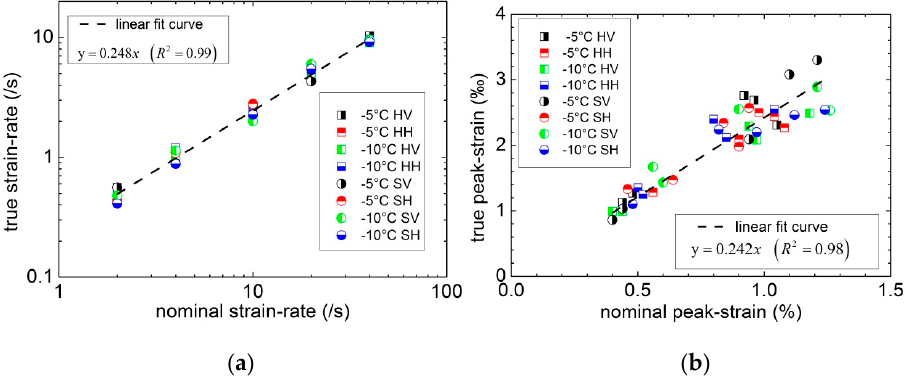
Figure 16. Relationship between the true deformation and the nominal deformation under dynamic loading conditions: ( a ) scatter plot of true strain-rate versus nominal strain-rate; and ( b ) scatter plot of true ultimate strain versus the nominal ultimate strain.